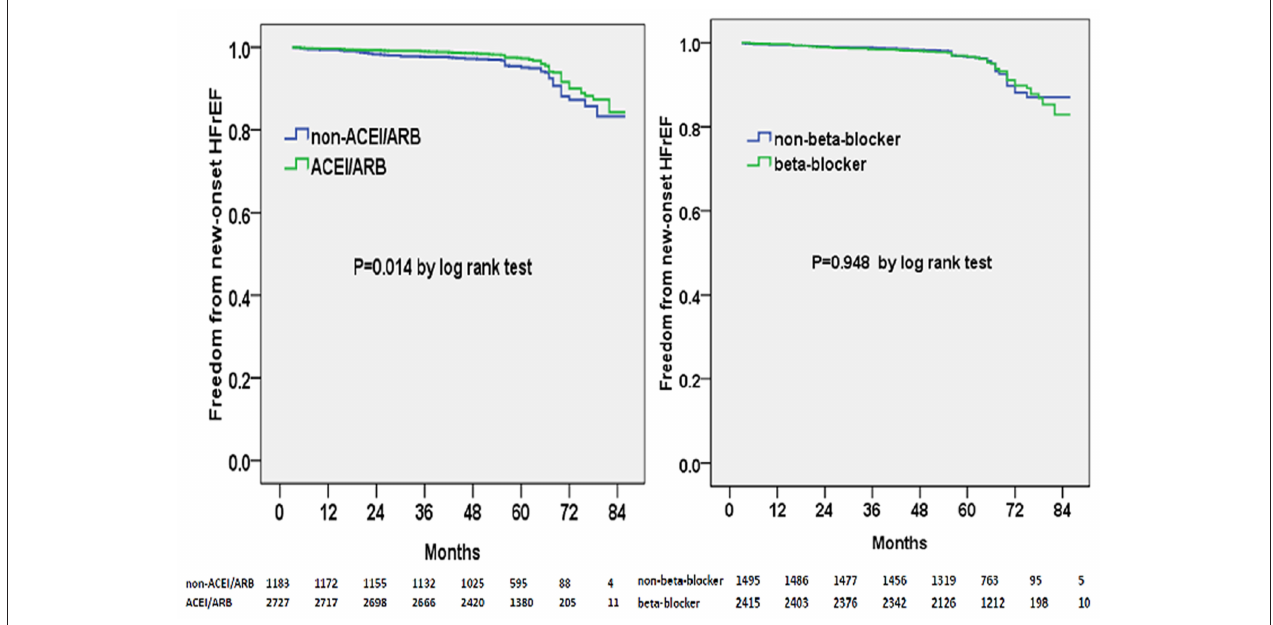
FIGURE 3 | Kaplan–Meier curves of freedom from new-onset HFrEF for different medical treatments. The numbers at the bottom of the figure are “number at risk”.